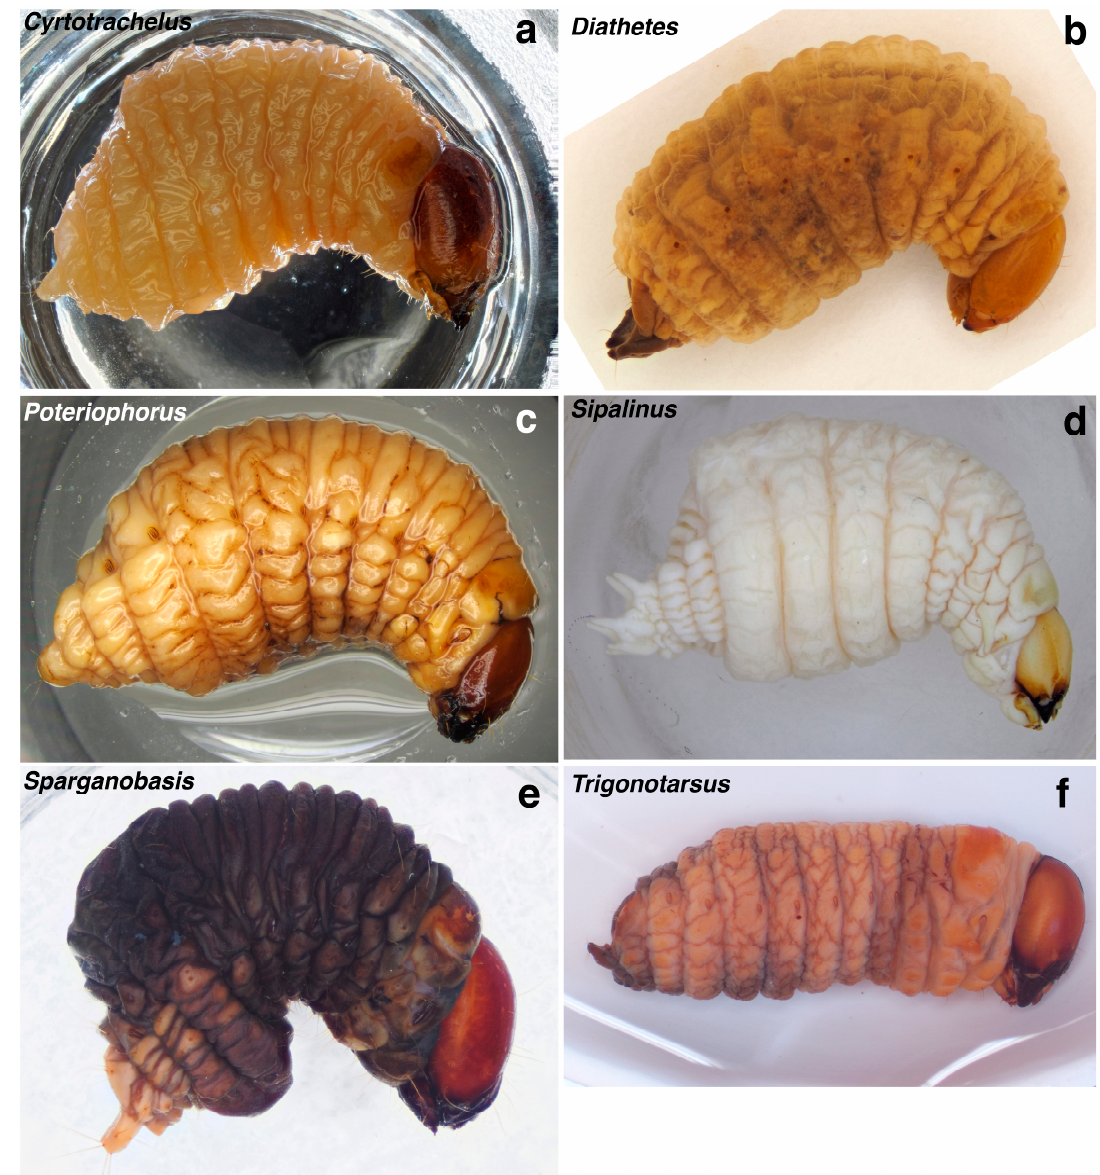
Figure 4. Larvae, lateral view: ( a ) Cyrtotrachelus ; ( b ) Diathetes ; ( c ) Poteriophorus ; ( d ) Sipalinus ; ( e ) Sparganobasis ; and ( f ) Trigonotarsus